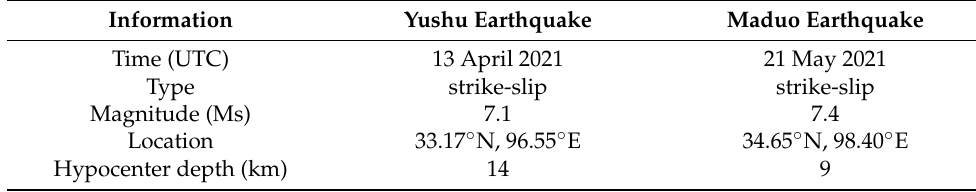
Table 2. Information of the Yushu EQ and the Maduo